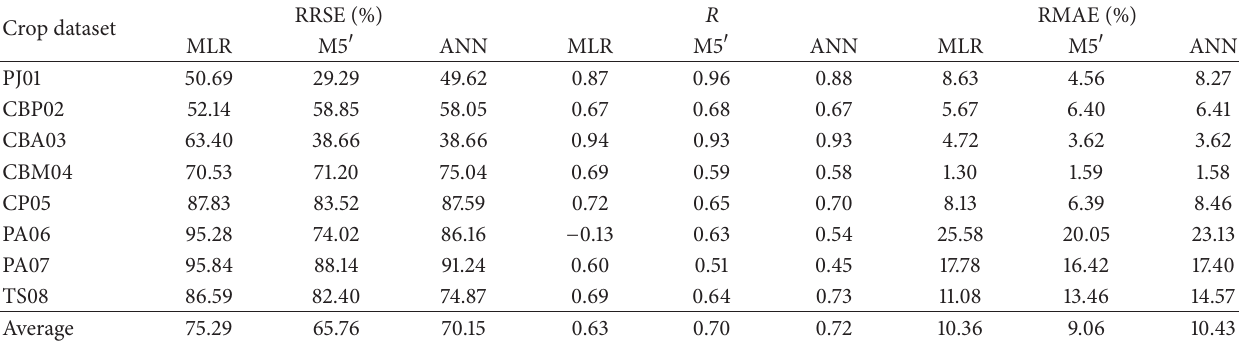
Table 3: RRSE, 𝑅 , and RMAE measures using the OAS on testing dataset. Crop dataset